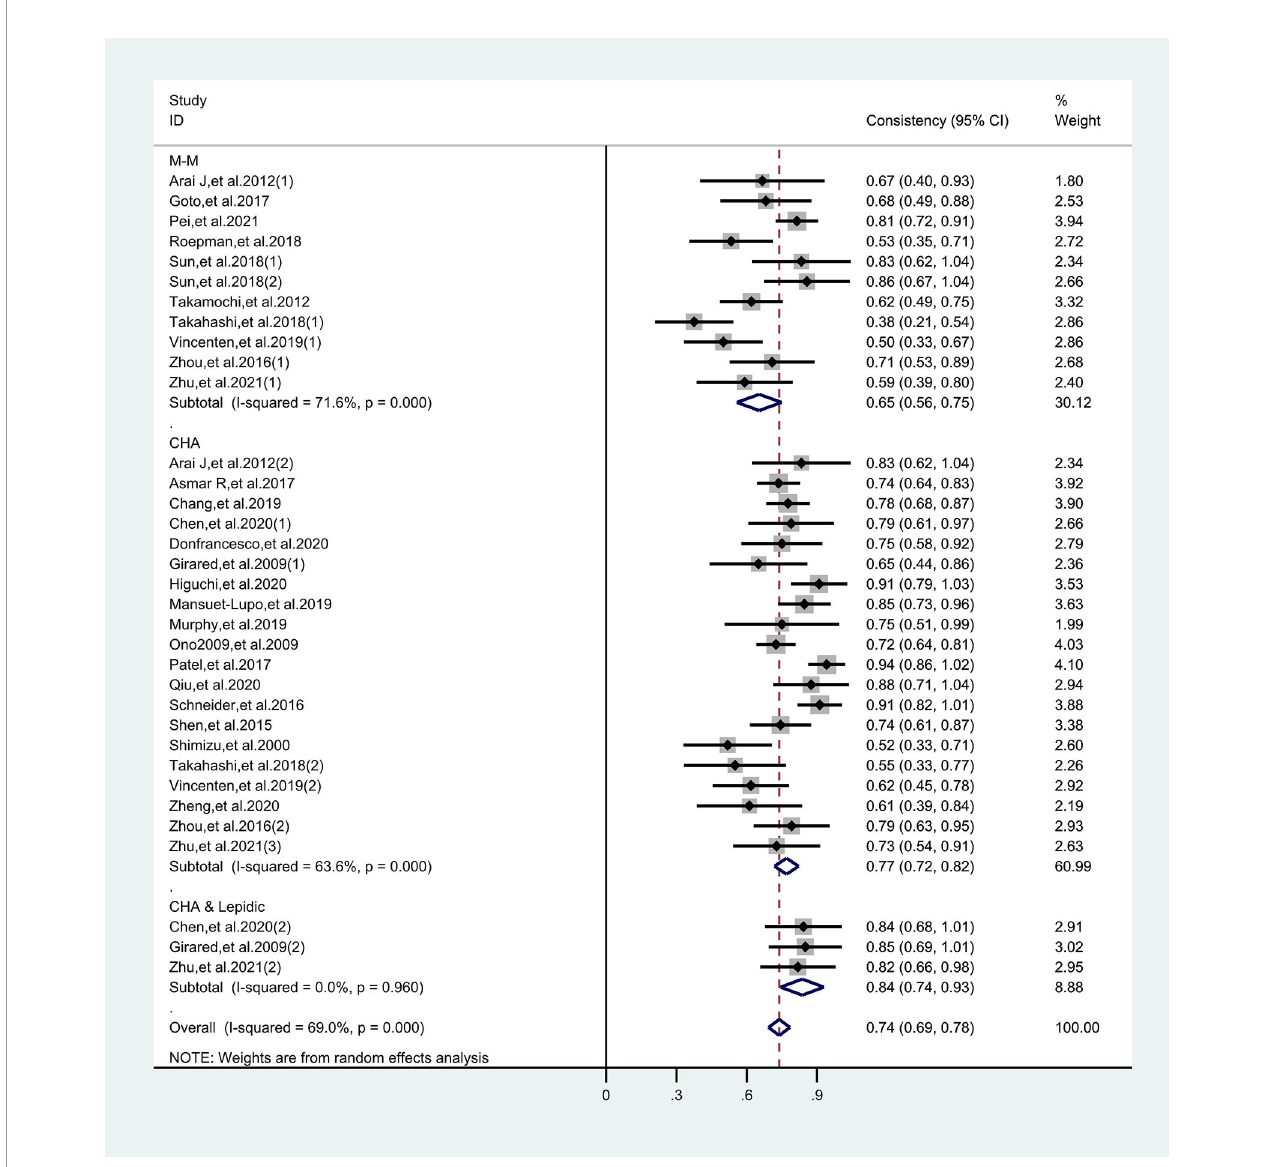
FIGURE 5 | Forest plots of consistency for each histological method in the differential diagnosis of MPLC and